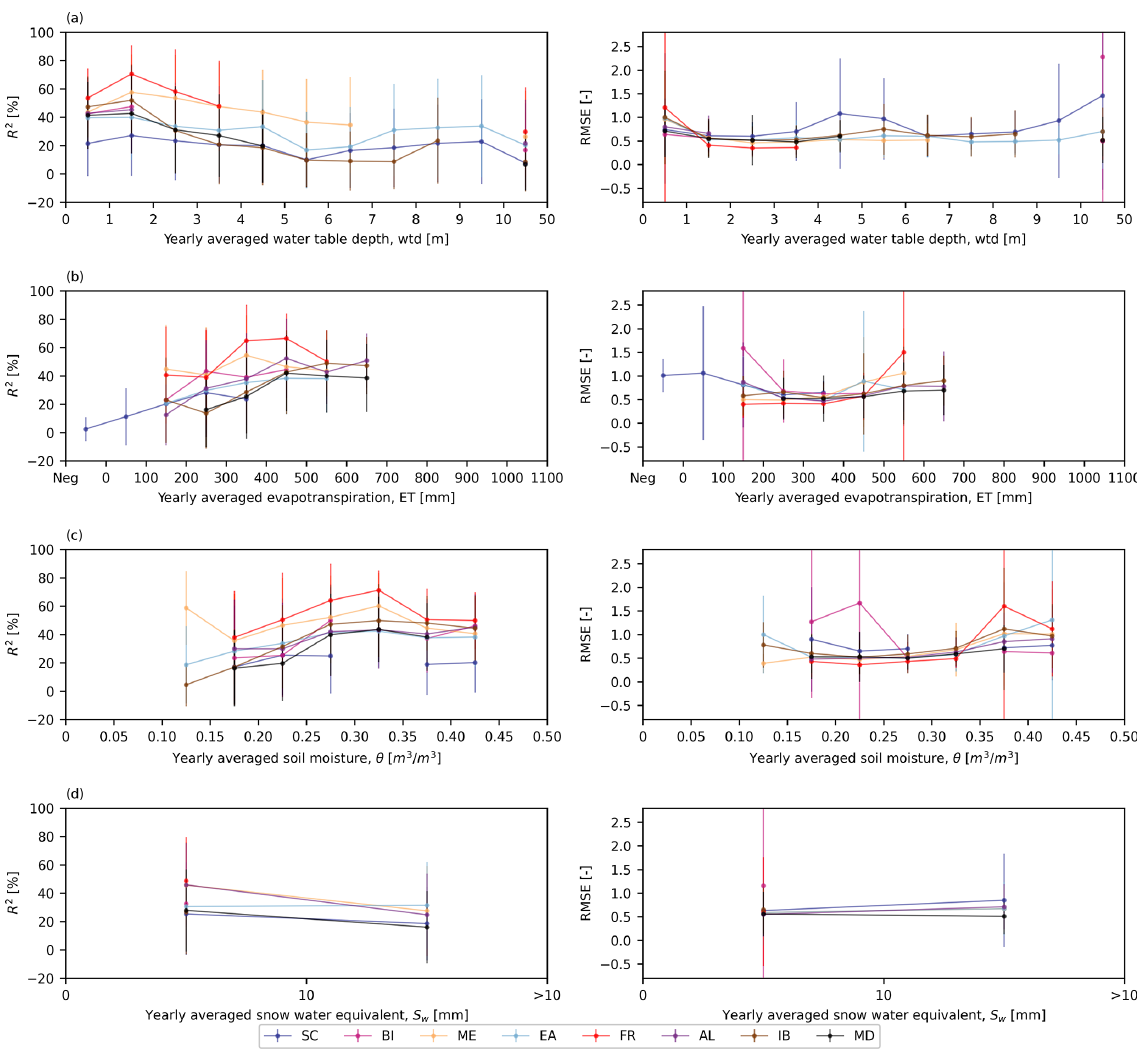
Figure 6. Averages and standard deviations of the test R 2 scores (left) and RMSEs (right) over the categorized results. Shown are the yearly averaged (a) wtd, (b) ET, (c) θ , and (d) S w . The averages are indicated as dots, while the bars indicate standard deviations. The different colors reflect test results in different PRUDENCE